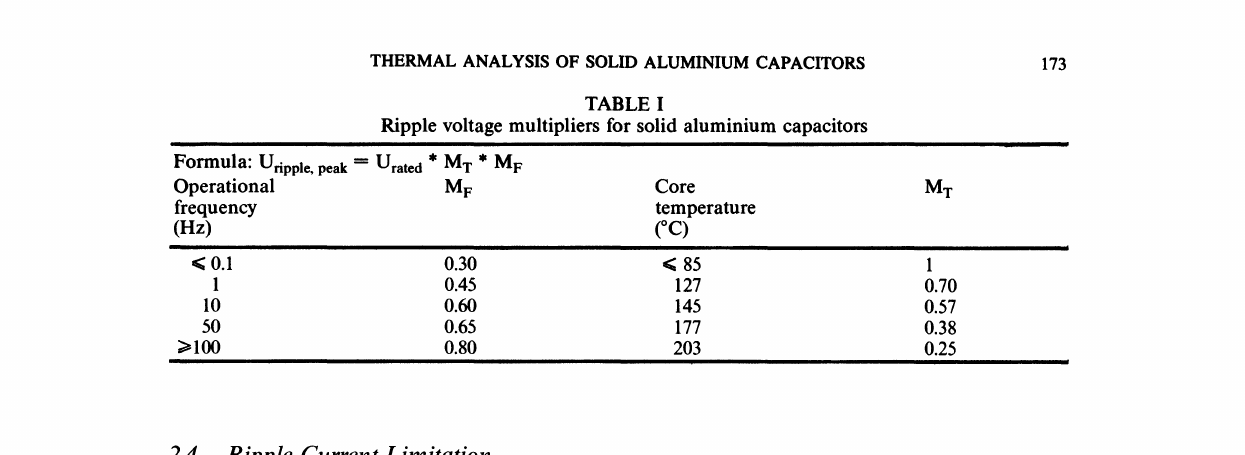
TABLE Ripple voltage multipliers for solid aluminium capacitors